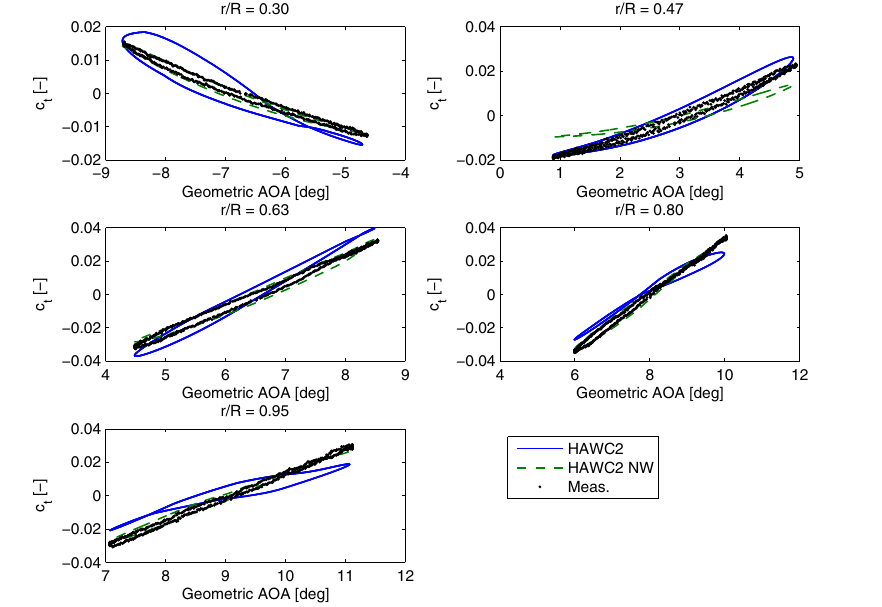
Figure 7. Case O47010. Variation about mean c t